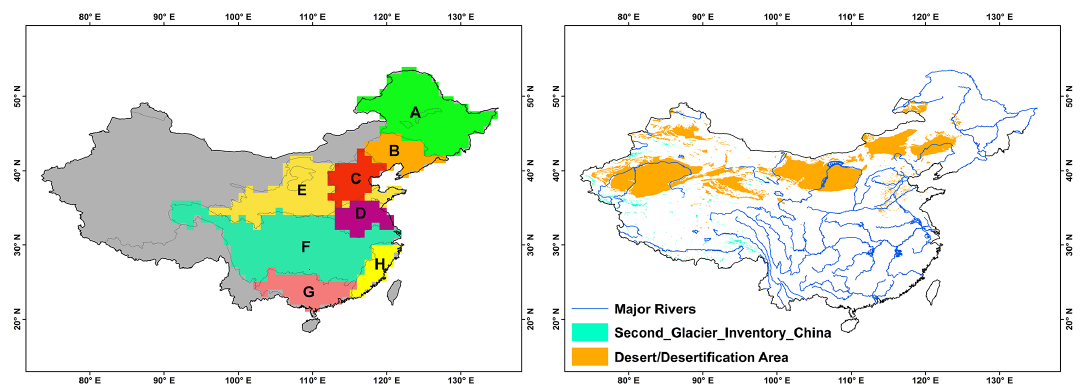
Figure 1. Schematic diagrams of research area (A: Heilongjiang River, B: Liao River, C: Hai River, D: Huai River, E: Yellow River, F: Changjiang River, G: Zhujiang, H: southeast rivers).